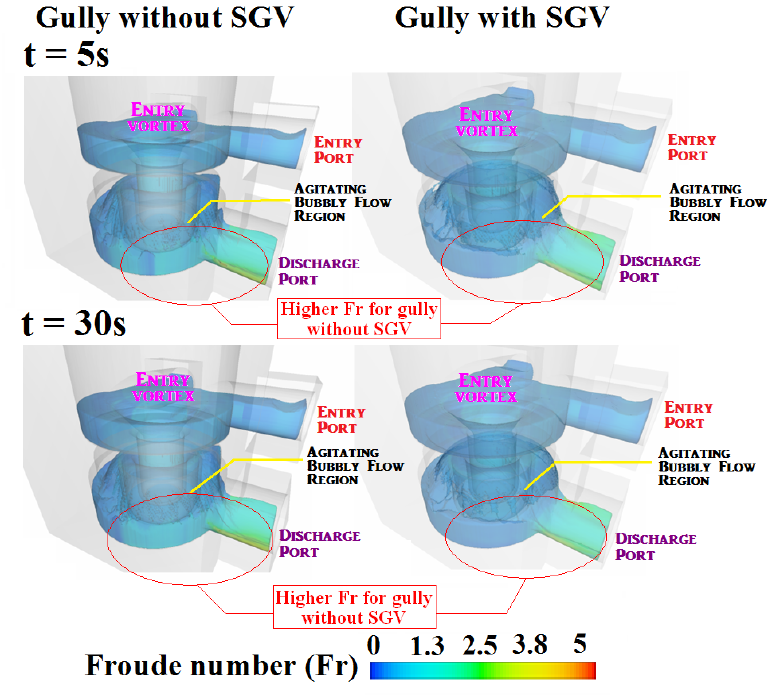
Figure 4. Three dimensional distributions of instant Froude number reflecting the overall flow structures in gullies with and without